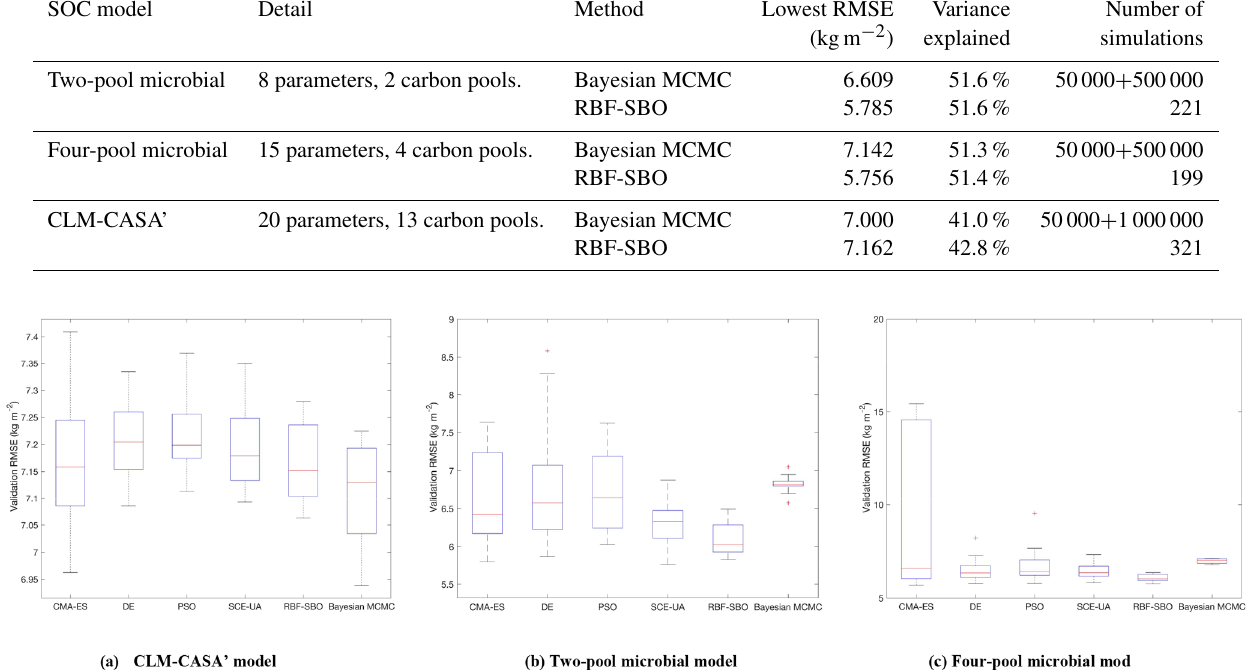
Figure 4. The RMSEs of the different optimization algorithms: (a) CLM-CASA’ model; (b) two-pool microbial model and (c) four-pool microbial model. The box plots show the means and the quartiles spreading over a total of 50 calibration runs. The central line indicates the median, the bottom and top of the box are the first and third quartiles, the black bottom and top lines out of the rectangles are the maximum and minimum and the red crosses represent the outliers. The number of simulations of the five algorithms is 100 and the number of simulations of the Bayesian MCMC is presented in Table